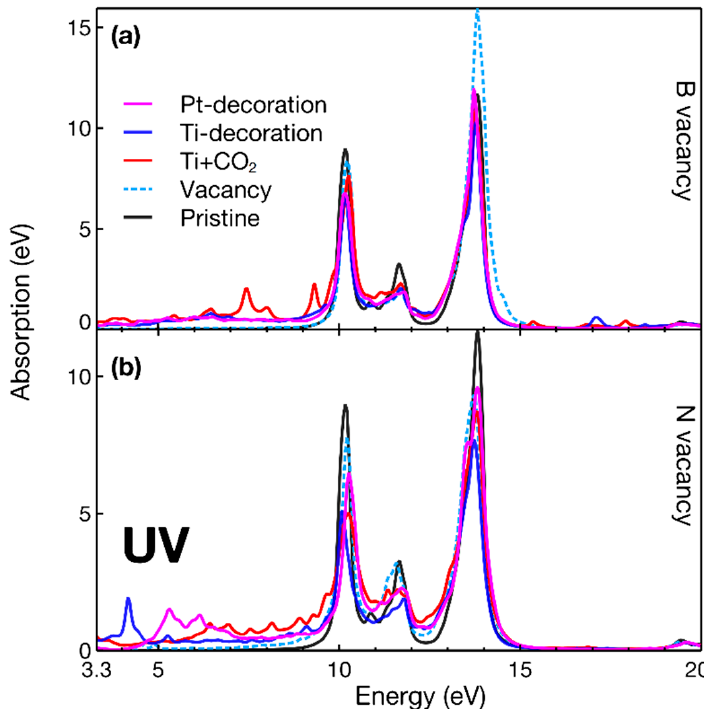
Figure 5. Absorption in the ultraviolet region for the cases considered. In ( a ) we see the cases with the B atom removed from the hBN surface, while in ( b ) we see those with the N atom removed. The introduction of a B vacancy increases the absorption, but otherwise the response appears unchanged across cases.